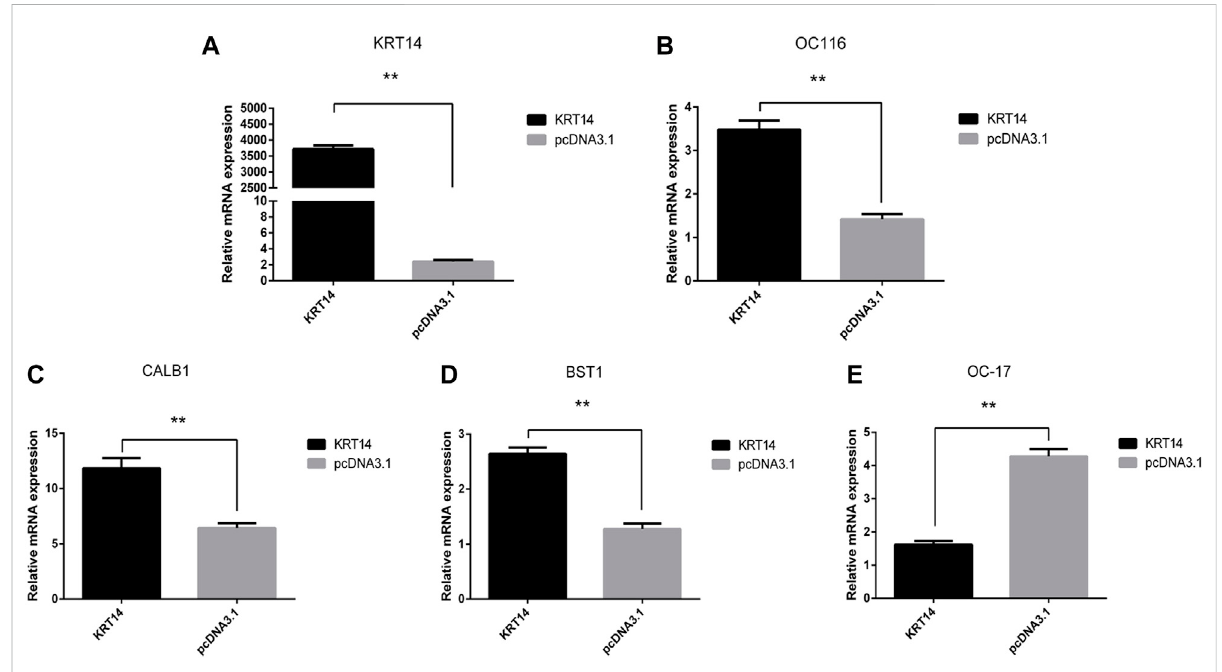
FIGURE 5 Effect of KRT14 on calcium metabolism and deposition of calcium carbonate in eggshell. (A – E) : Expression levels of KRT14, OC116, CALB1, BST1, and OC17